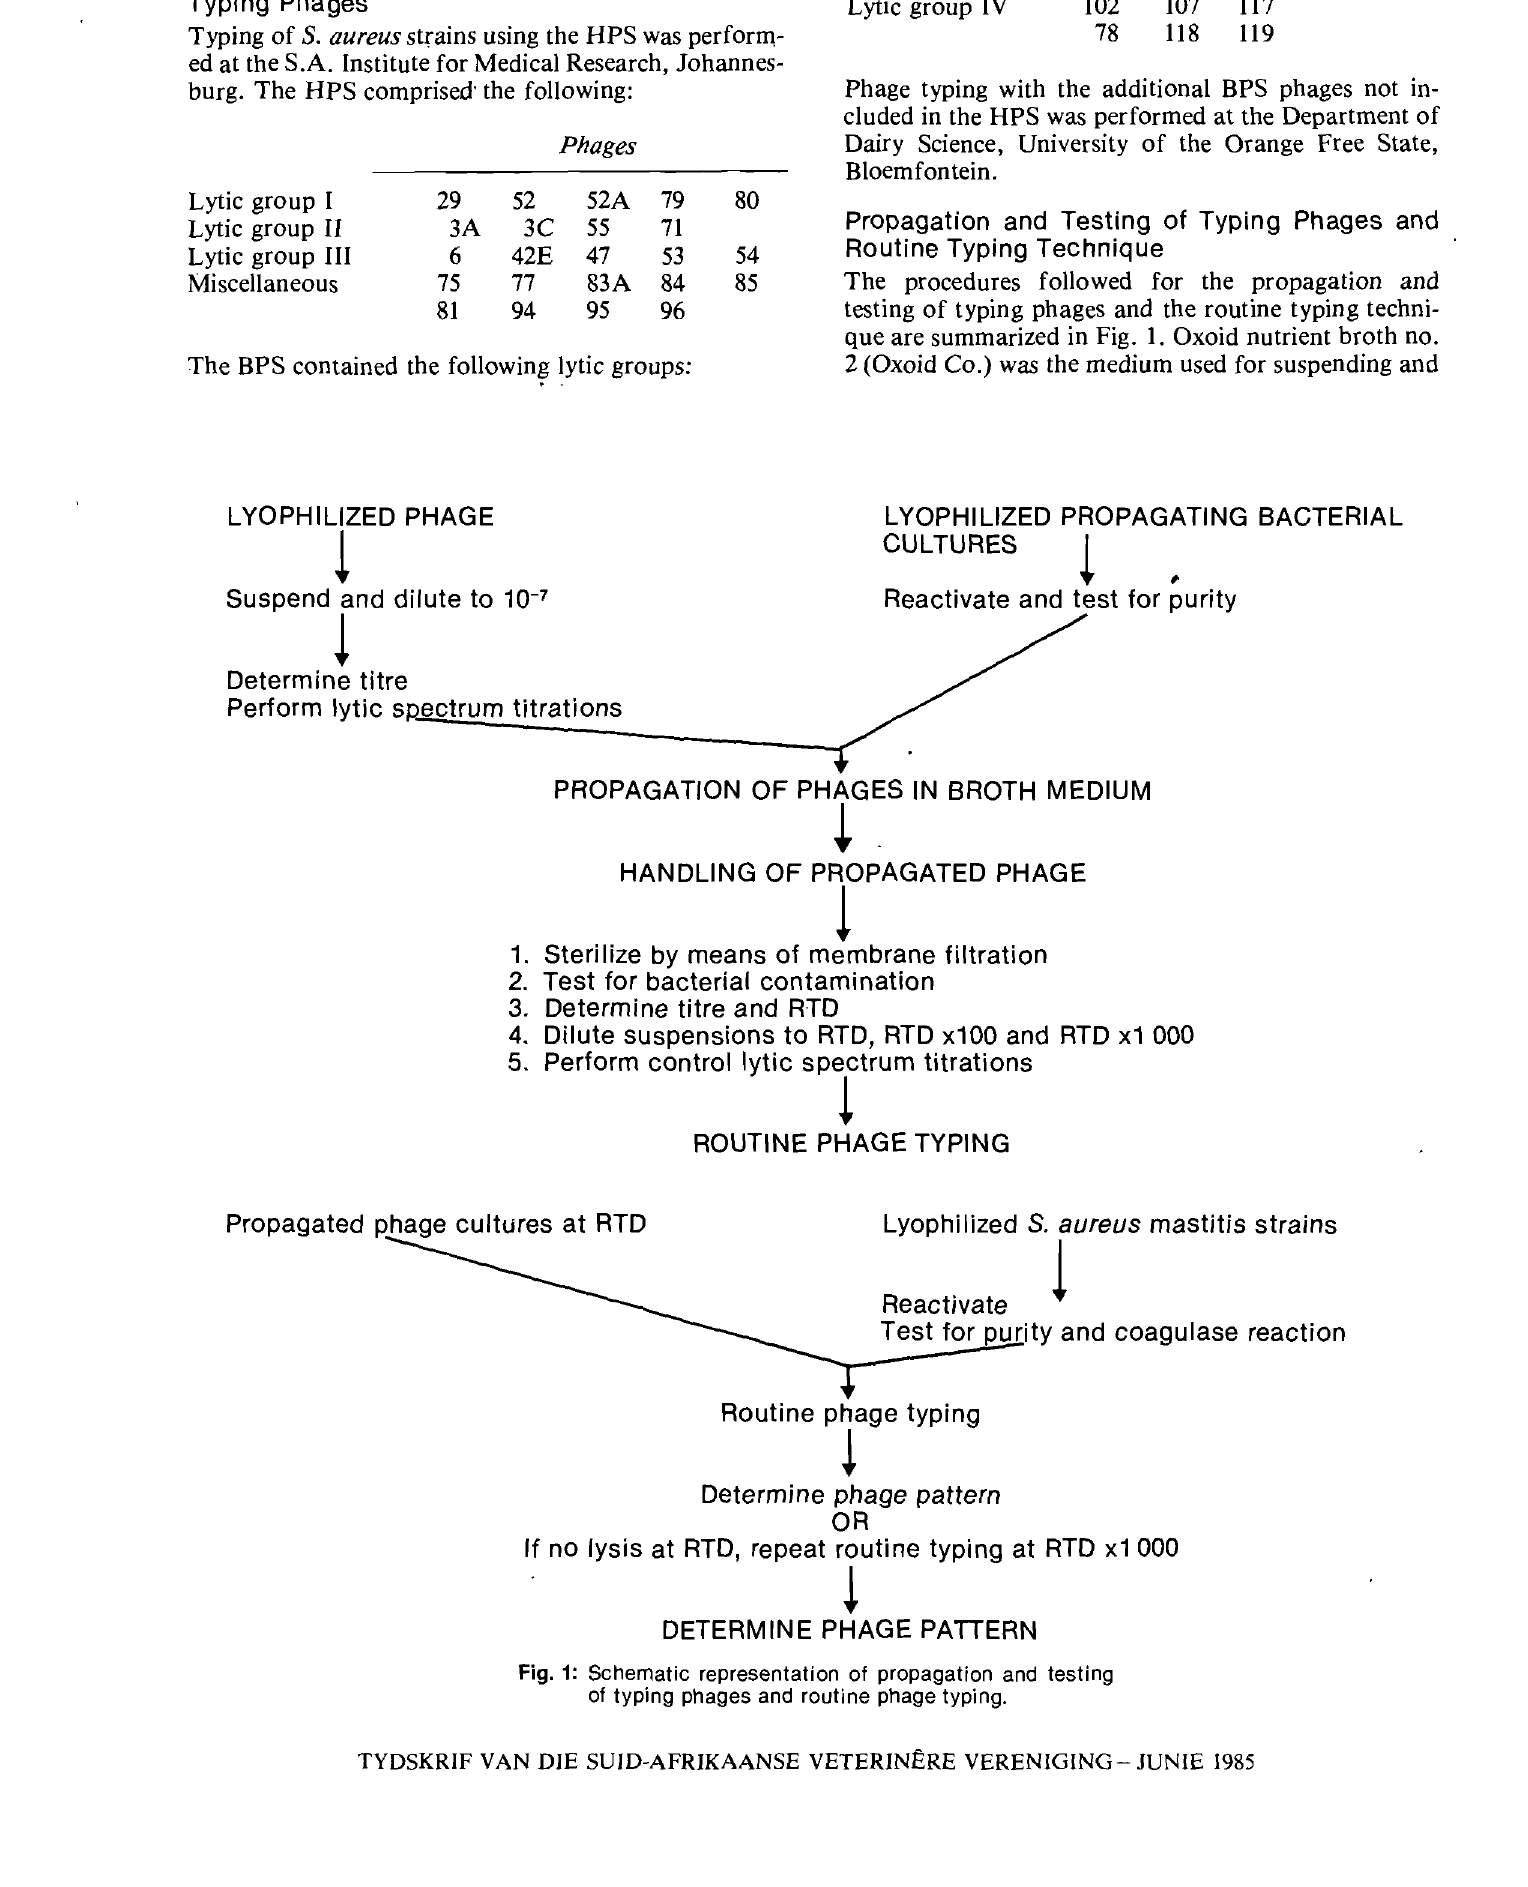
Fig. 1: Schematic representation of propagation and testing of typing phages and routine phage typing, TYDSKRIF VAN DIE SUlD-AFRIKAANSE VETERINERE VERENIGING - JUNIE